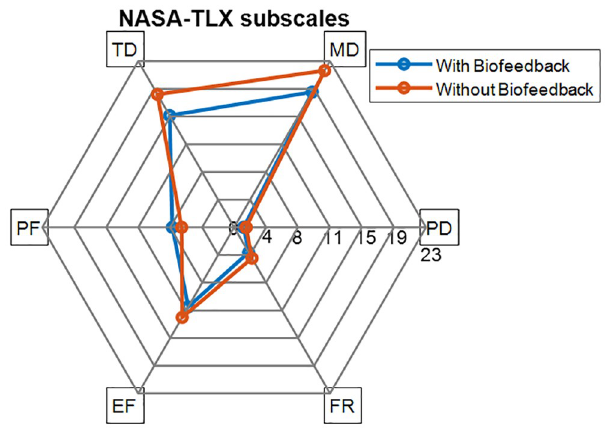
Fig 6. The weighted scores of the NASA-TLX subscales in the automatic sessions (with biofeedback) and manual sessions (without biofeedback), where the subscales range from 0 to 33 indicating low to high levels. The subscales are Mental Demand (MD), Temporal Demand (TD), Performance (PF), Effort (EF), Frustration (FR), and Physical Demand (PD).